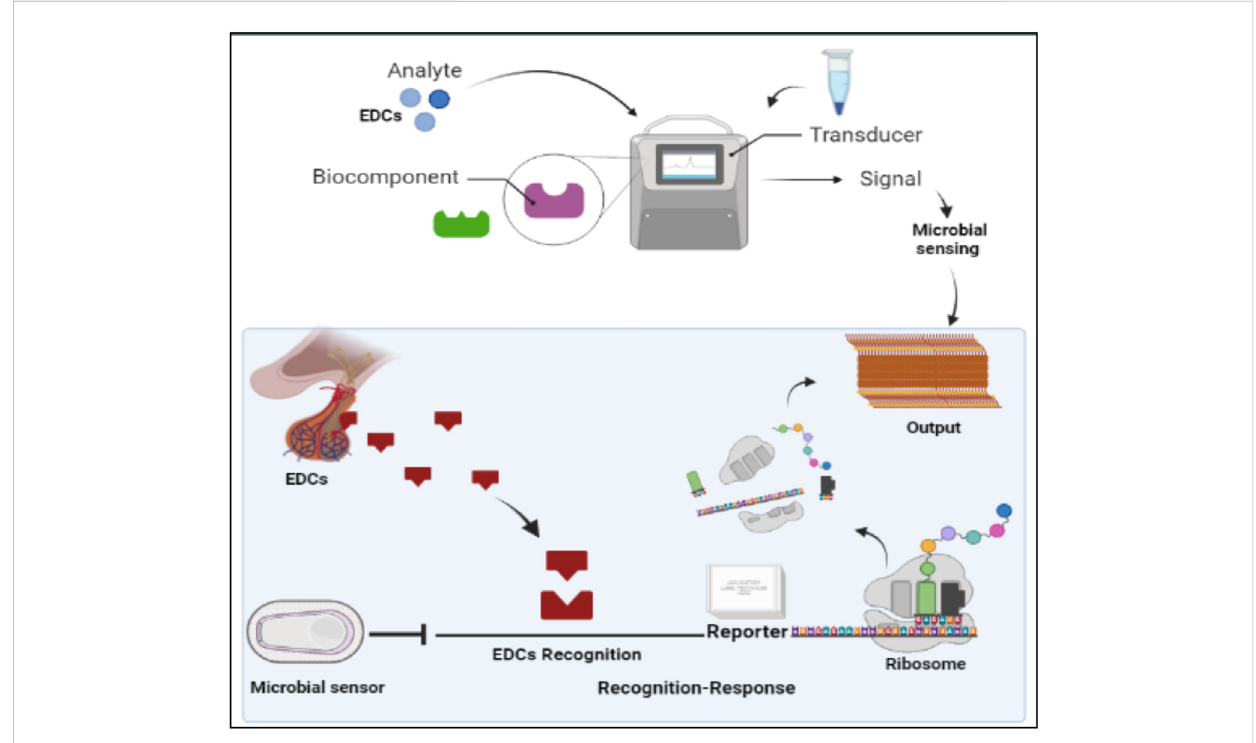
FIGURE 4 The illustration of cell free microbial sensors for monitoring EDCs. Cell free microbial sensors were used to detect EDCs. The downstream reporter gene is activated for transcription and then translated for reporter protein production in a cell free